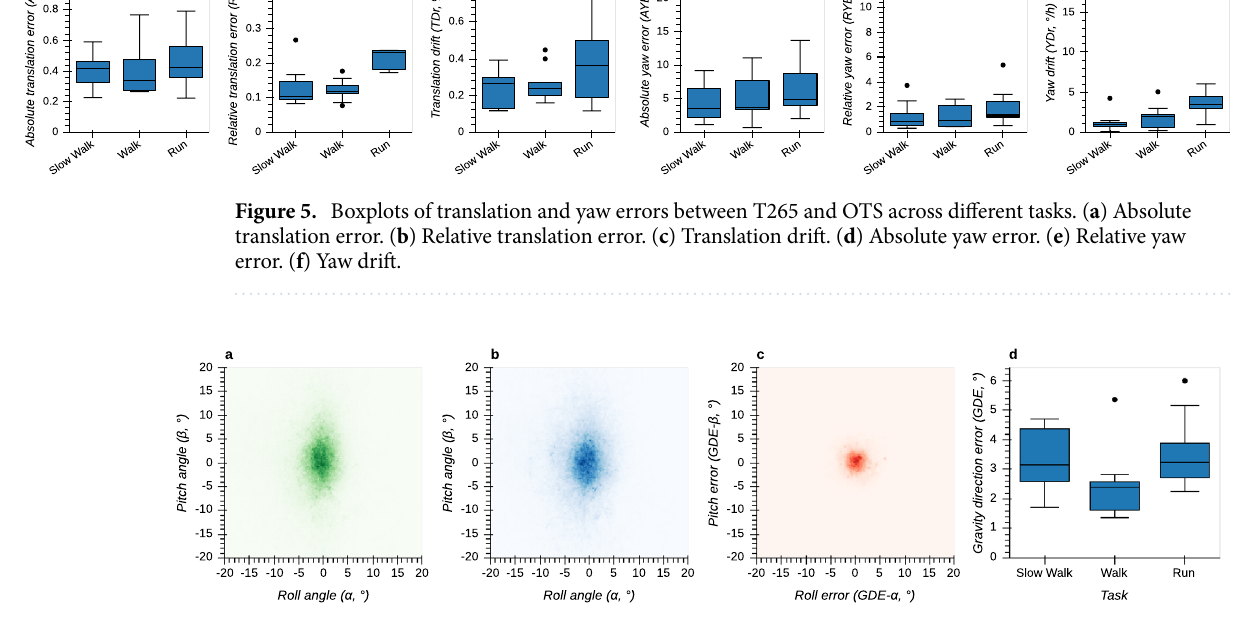
Figure 6. Gravity direction measured by T265 and OTS and corresponding errors. Positive pitch angles correspond to forward pitch, positive roll angles to rightward roll. ( a ) Bi-variate histogram of pitch and roll angles measured by the OTS. ( b ) Bi-variate histogram of pitch and roll angles measured by the T265. ( c ) Bi-variate histogram of pitch and roll errors between T265 and OTS. ( d ) Boxplot of gravity direction errors between T265 and OTS across different tasks.